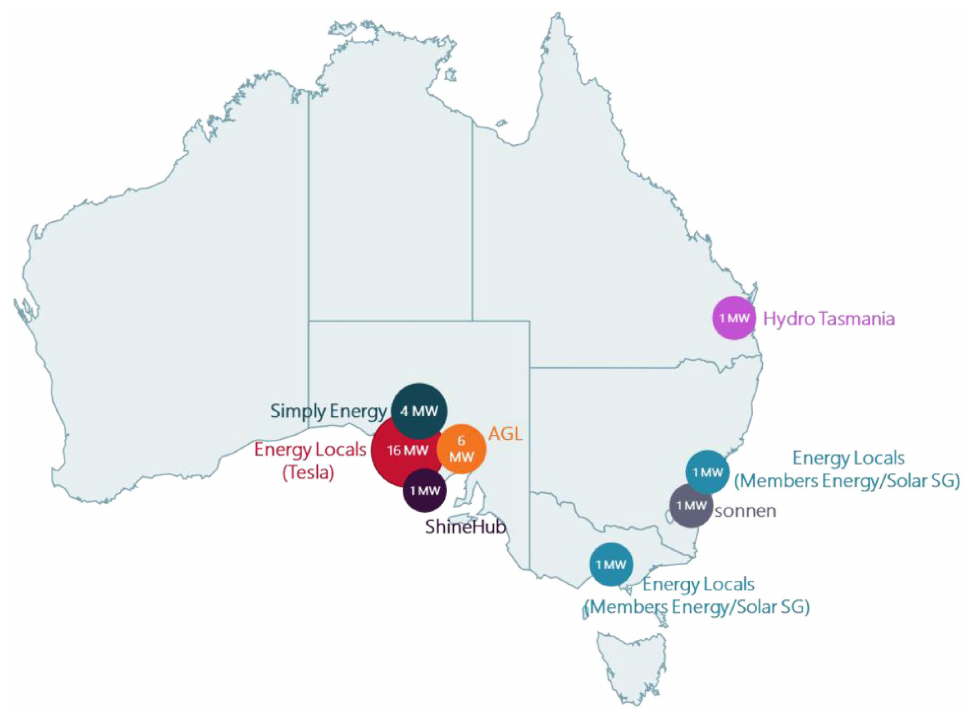
Figure 2. The location and size of VPPs in the AEMO’s VPP demonstration [30].